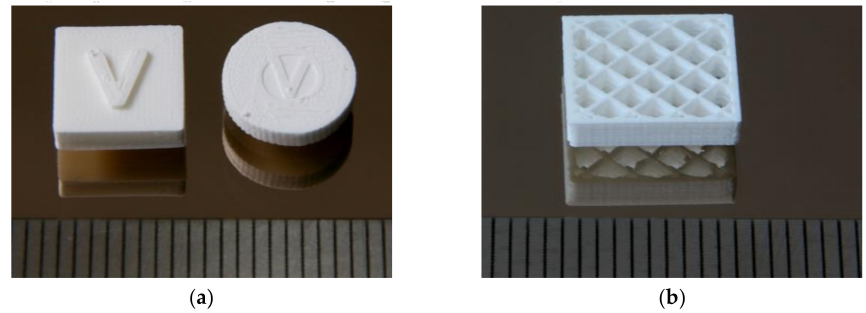
Figure 4. Printed test structures. ( a ) Massive body (left: cuboid, right: disc) and ( b ) Open grid. Table 1. Fused filament fabrication (FFF) Printing parameters for the new feedstock system. Item PEG /